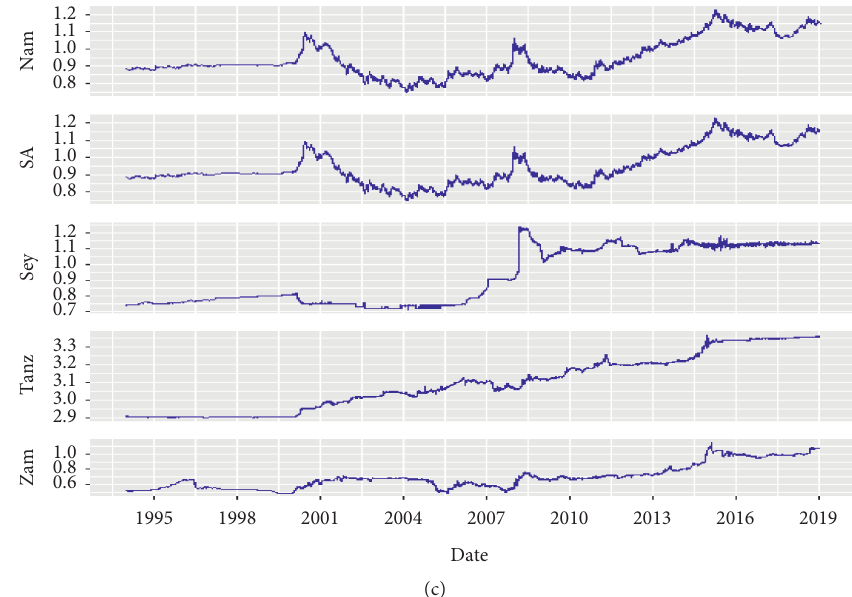
Figure 1: Plots of log of the daily real exchange rate of 15 countries of SADC (Figure 1 is reproduced from Adam et al.